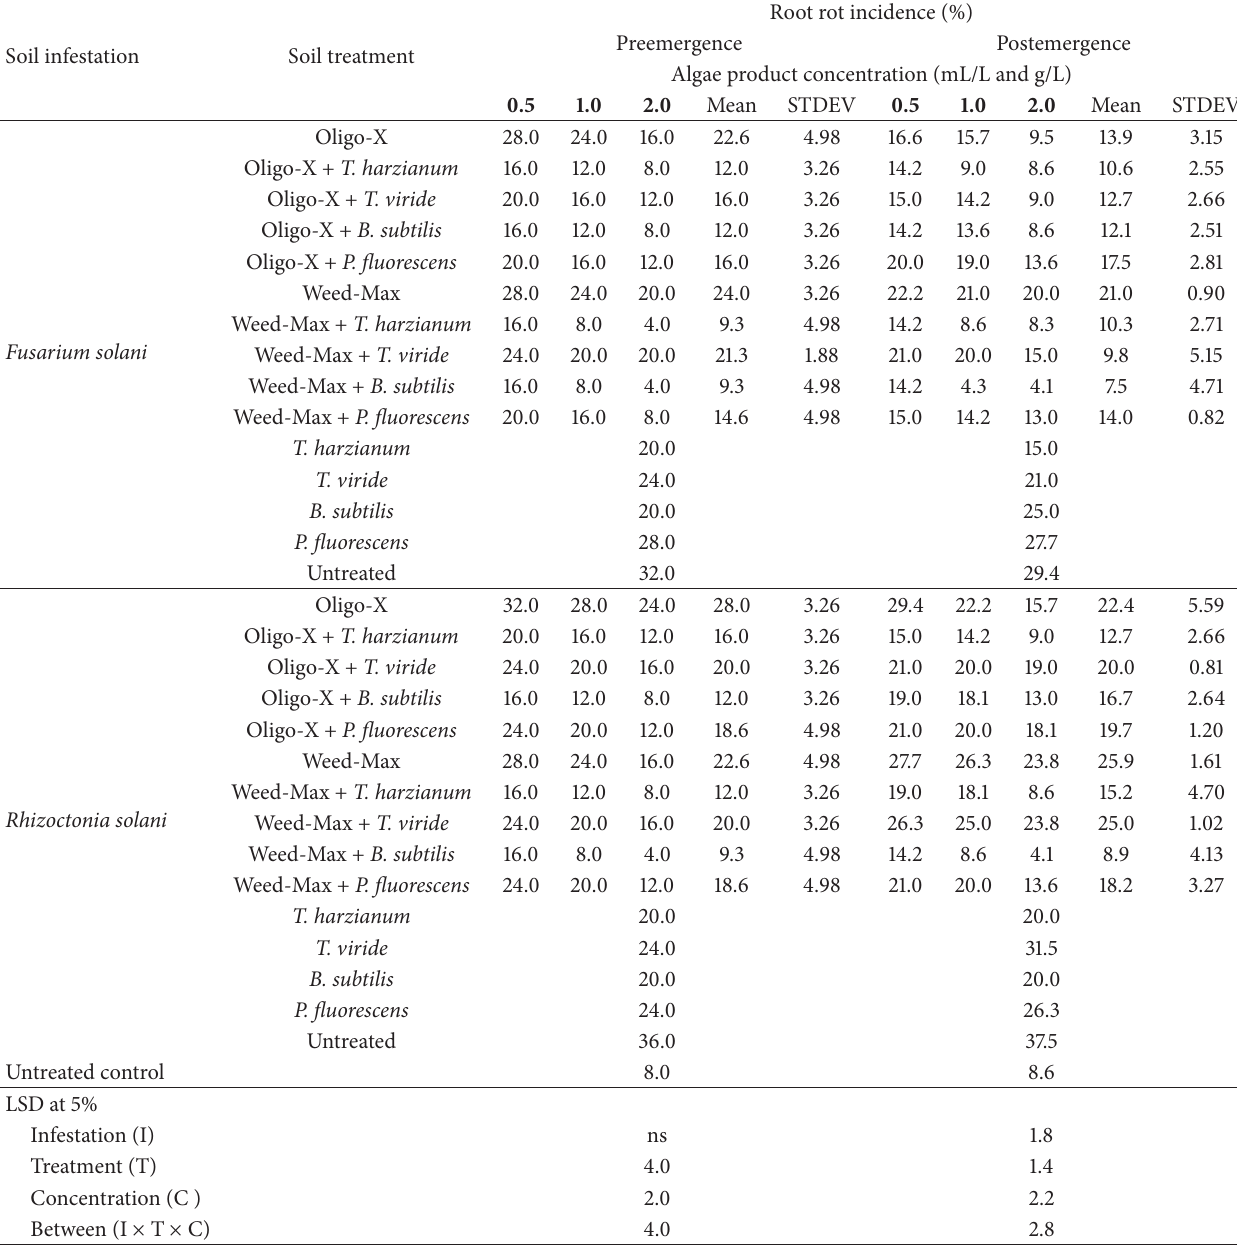
Table 1: Effect of integrated soil treatment with algae compound and bioagents against root rot incidence of cucumber under greenhouse